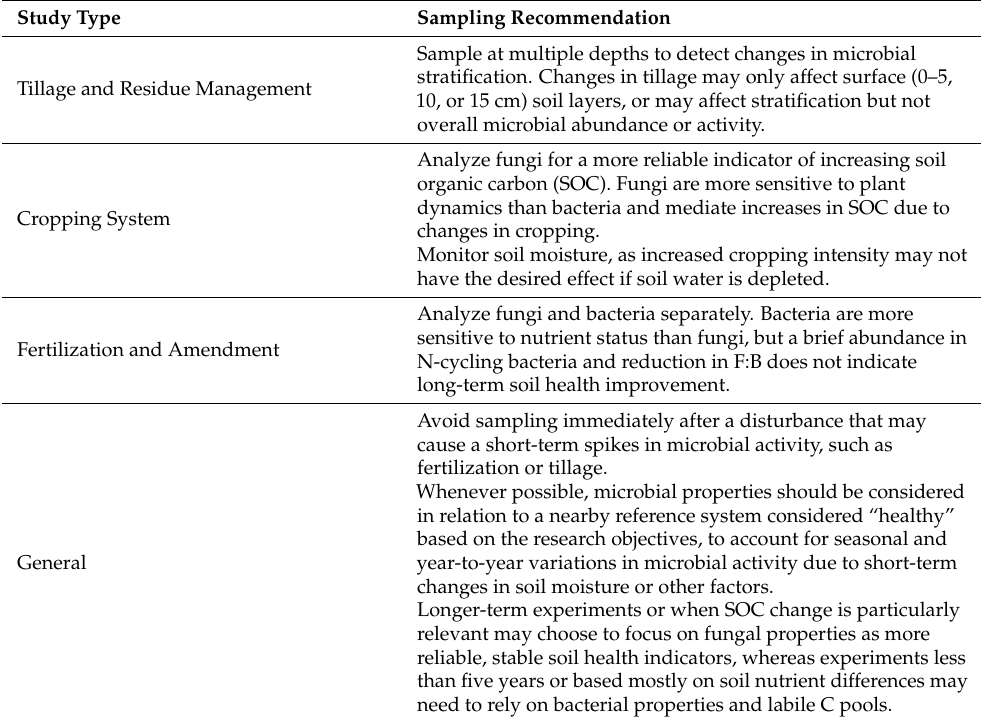
Table 1. Sampling recommendations for the different management systems reviewed in this